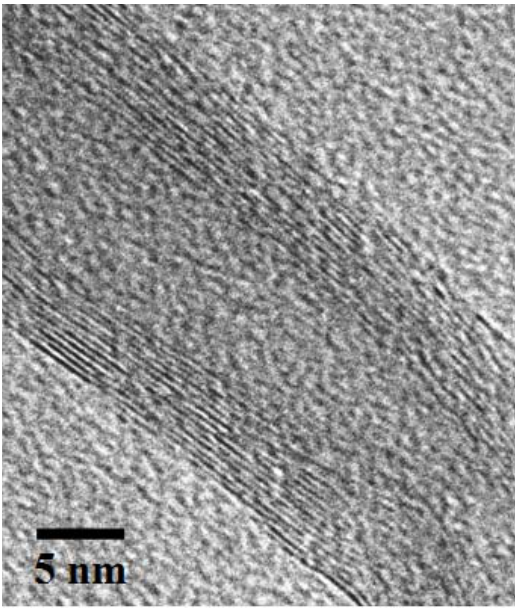
Figure 2. High resolution TEM image of the produced MWCNT grown by the CVD